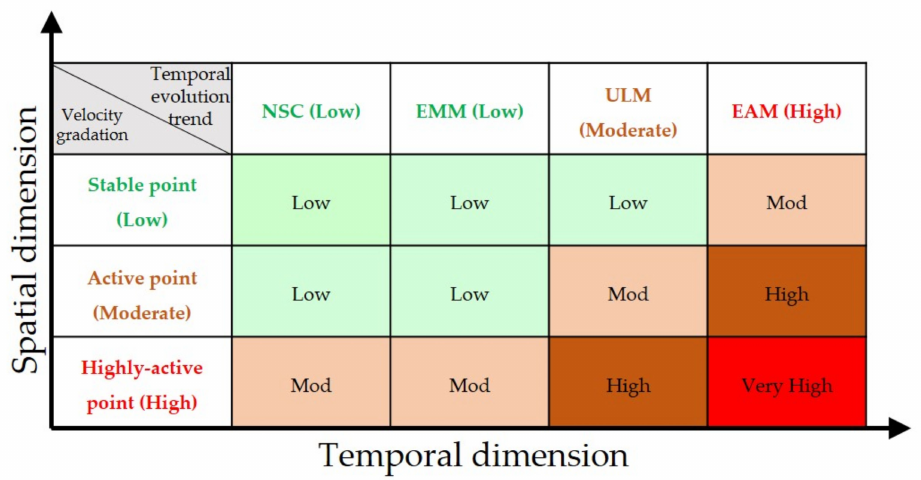
Figure 5. Qualitative instability matrix of the deformation